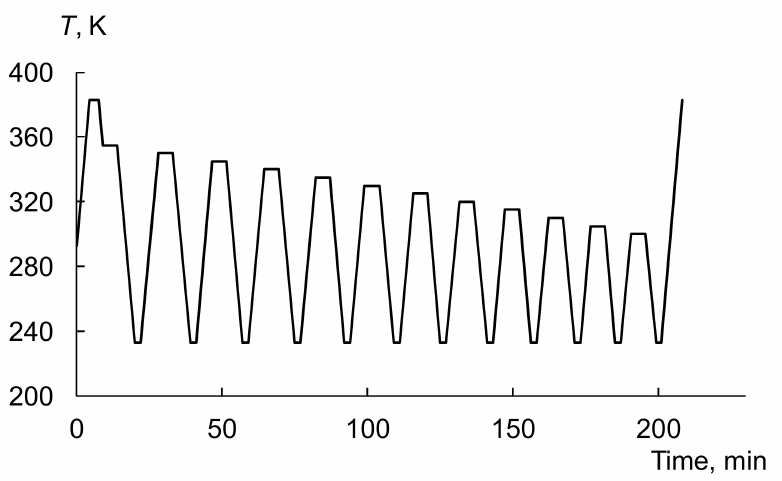
Figure 2. Temperature–time protocol of thermal fractionation by SSA implemented in this study. XRD patterns were recorded using an X-ray source with a rotating copper anode, Rotaflex RU-200 (Rigaku, Tokyo, Japan), with primary monochromatic CuK α radiation ( λ = 1.542 Å), equipped with a horizontal goniometer, Rigaku D/Max-RC, in the scattering range (2 θ ) of 5 ◦ − 55 ◦ at room temperature. A θ –2 θ scanning of the sample’s films was carried out in the “reflection” geometry according to the Bragg–Brentano scheme. The measurement was carried out in continuous scanning mode at a speed of 1 degree/min and a step of 0.04 degrees. The diffractograms were processed using data from [52–54]